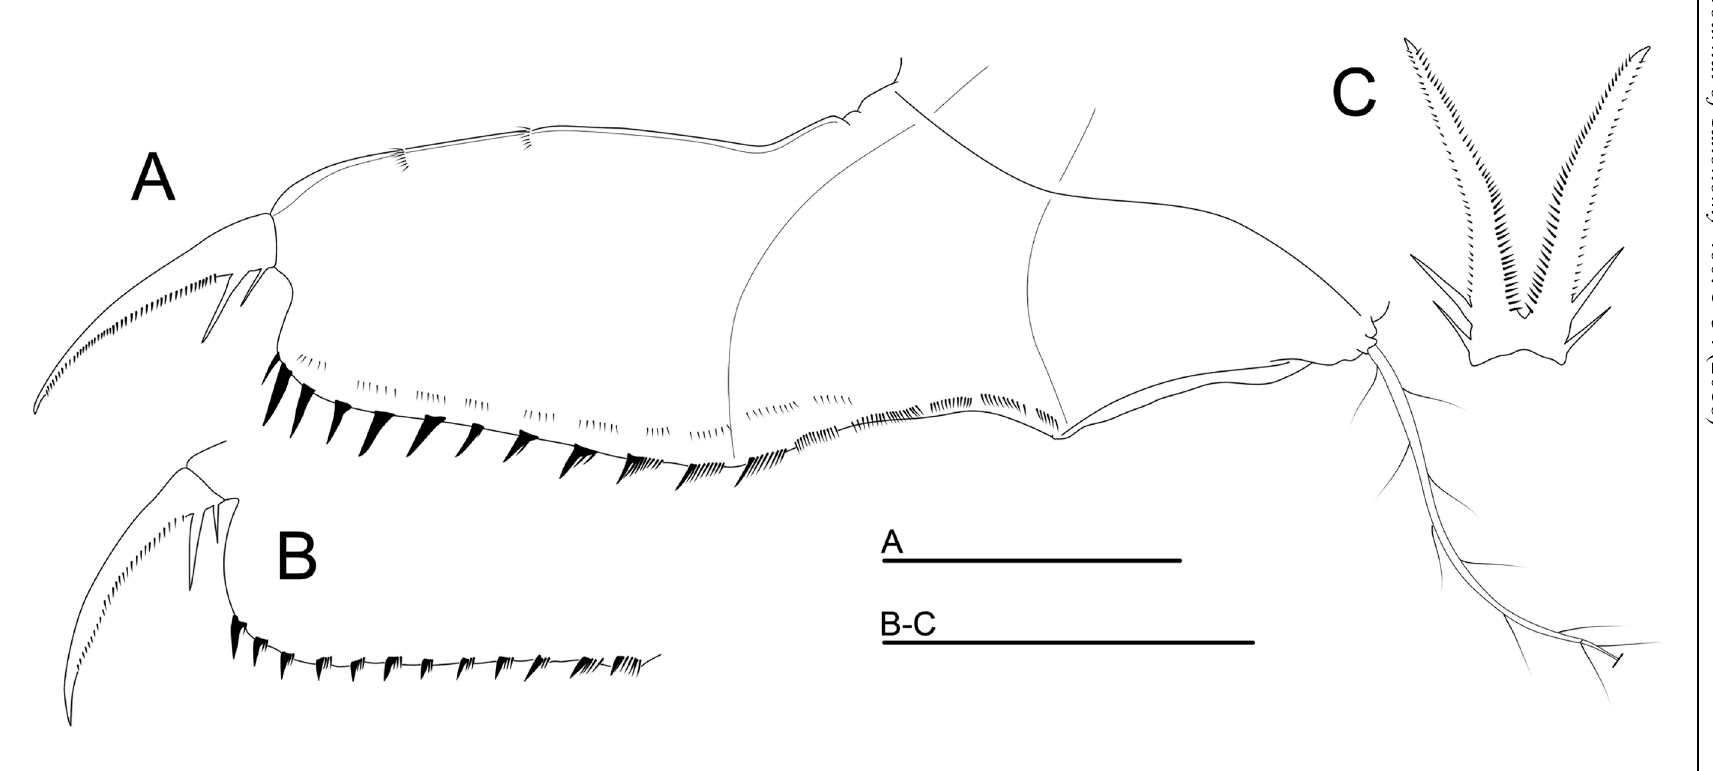
Fig. 6. Disparalona ( Mixopleuroxus ) hamata (Birge, 1879), parthenogenetic female. A–C . Postabdomen. A . Lateral view. B . Marginal denticles of the juvenile. C . Dorsal view of postabdominal claw (separation between claws not represented). Scale bars = 50